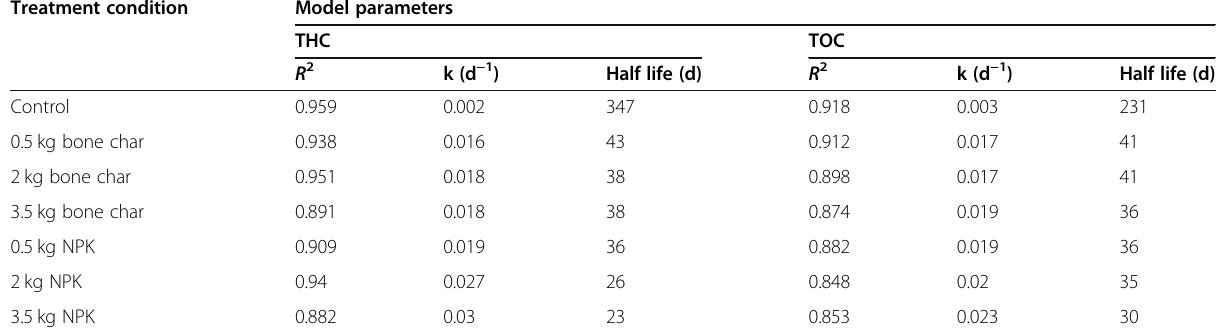
Table 5 Summary of the kinetic model parameters for THC and TOC reduction Treatment condition